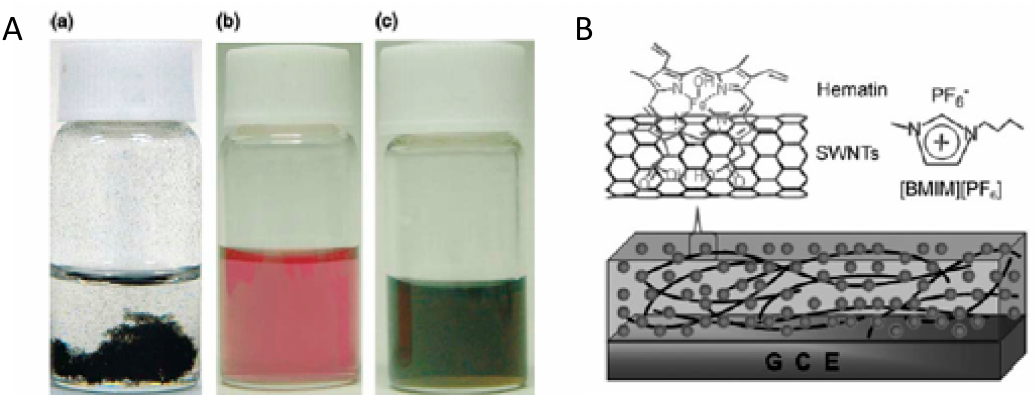
Figure 8. Photos of ( A ) : (a) a DMF dispersion of p-SWCNT solely, (b) a DMF solution of ZnPP and (c) a transparent DMF solution/ dispersion of p-SWCNT–ZnPP [77]. ( B ): Diagram of a porphyrin/SWCNT-[BMIM][PF 6 ]-modified glassy carbon electrode (GCE) [78].